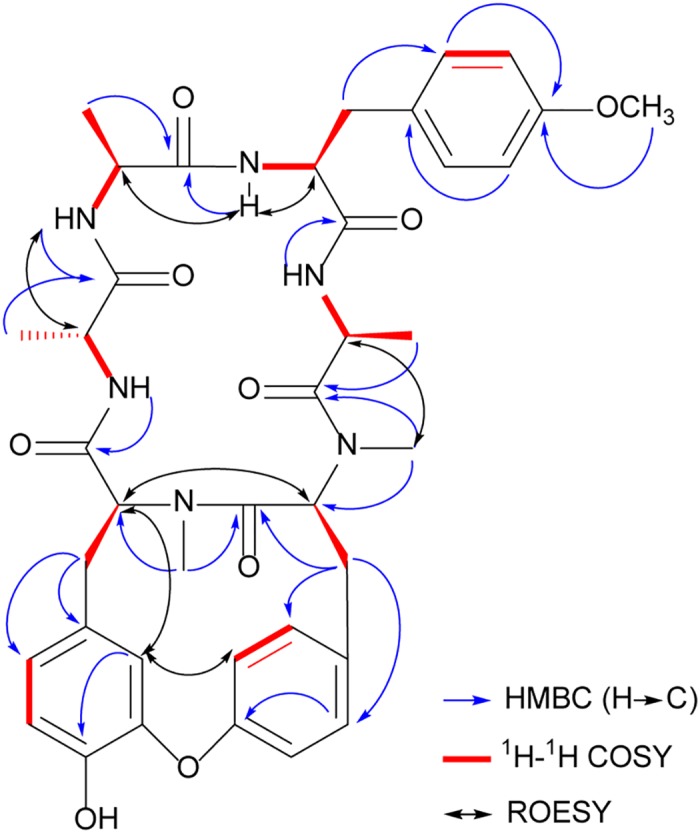
Key HMBC, 1H-1H COSY, and ROESY correlations of 1.